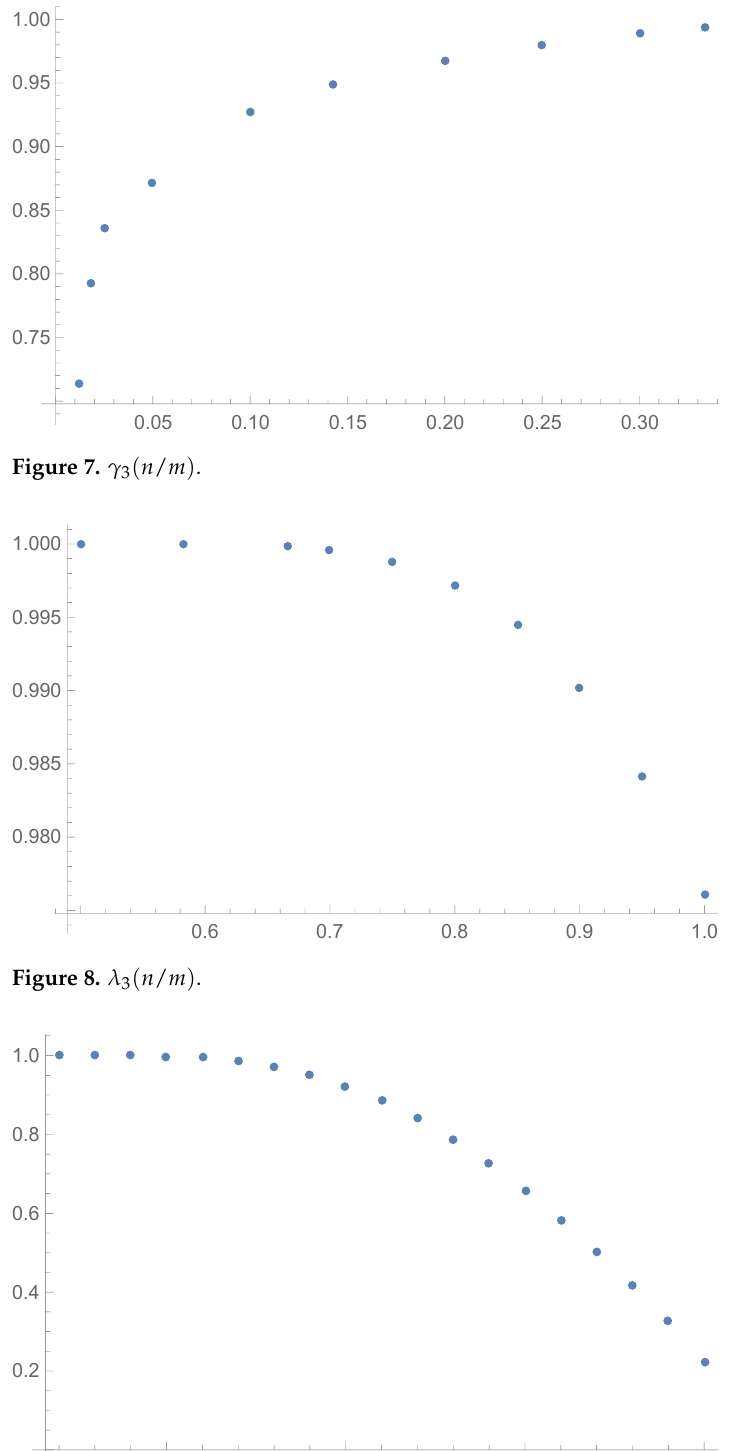
Figure 9. γ 3 ( n / m )